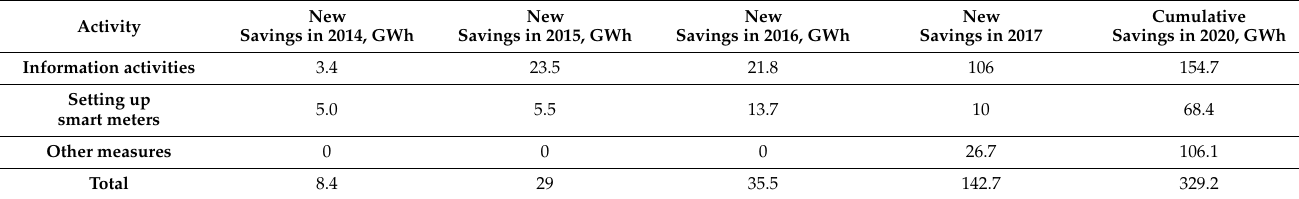
Table 1. Energy savings achieved by the EEOS parties during the starting period